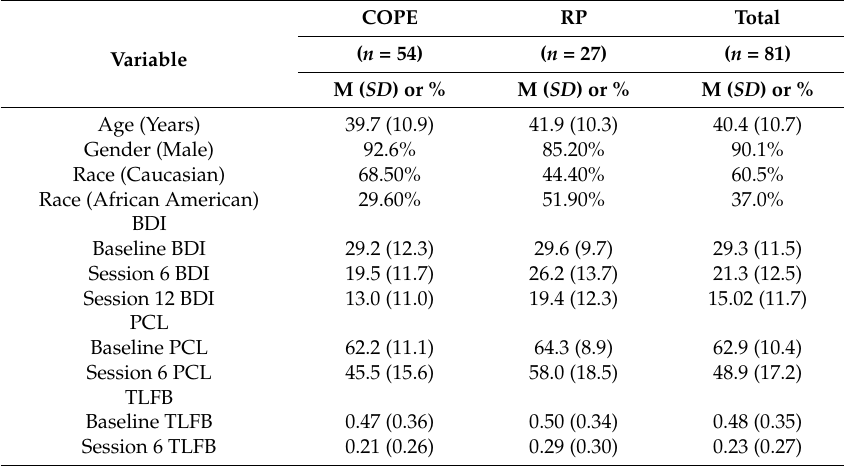
Table 1. Demographics and primary outcome measures among participants in the COPE and RP groups.